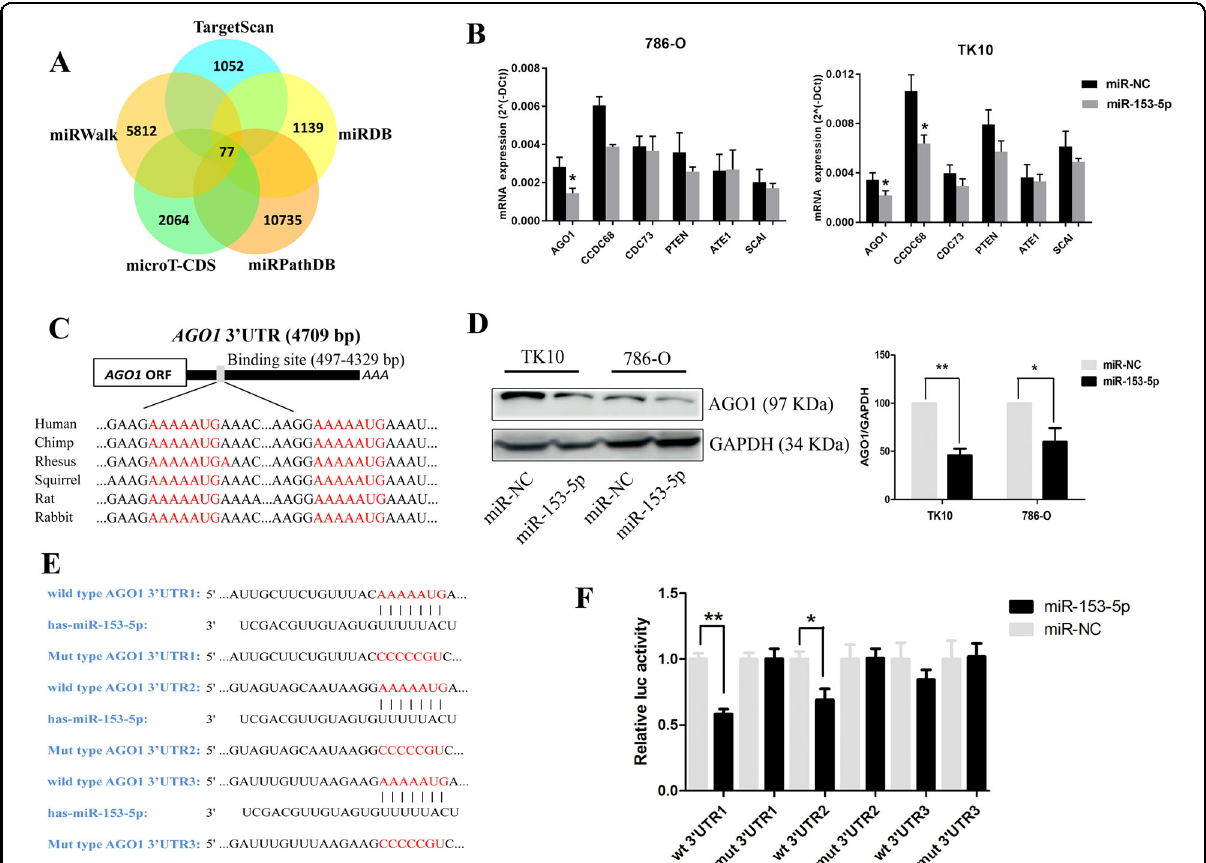
Fig. 4 Screen the potential targets of miR-153-5p and AGO1 was identi fi ed as its direct target. A Schematic illustration displaying the overlapped target genes of miR-153-5p predicted by microT-CDS, TargetScan, miRWalk, miRPathDB, and miRDB. B The mRNA expression of the top target genes were tested by qPCR in 786-O and TK10 after transfection with miR-153-5p mimics. C Sequence alignment of the predicted miR-153-5p- binding targets in the AGO1 3 ′ -UTR from six organisms. D The protein expression of AGO1 was tested in 786-O and TK10 after transfection with miR- 153-5p mimics by western blotting. E The sequence of binding targets of miR-153-5p in wild-type or mutant AGO1 3 ′ -UTR. F After transfection with miR-NC or miR-153-5p in HEK293T cells, the relative luciferase activity of mutant or wild-type AGO1 3 ′ -UTR was detected. All experiments were conducted at least three independent times and all the values were presented as mean ± SEM. * P < 0.05, ** P <